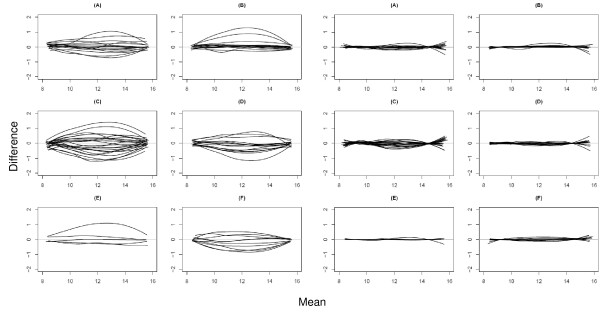
Average bias curves. Average bias curves (i.e. the loess smoothers) from MVA plots examining reproducibility in light of various systematic factors. The left set of six are pre-normalization; the right set of six are post-normalization. (A) Within plate technical replicates for the four cell lines on all four SAMs (n = 16 curves). (B) Within plate patient technical replicates for 200 ng of extraction 1 on first three SAMs (n = 15 curves). (C) Cell line technical replicates between SAMs (n = 24 curves). (D) Patient sample technical replicates between SAMs for 200 ng of extraction 1 (n = 15 curves). (E) Patient sample between extraction technical replicate for 200 ng (n = 5 curves). Replicate 1 was chosen arbitrarily. (F) Patient samples from extraction 1 comparing 25, 100, 400, 800 ng to 200 ng for two patients (n = 10 curves). Replicate 1 for 200 ng was chosen arbitrarily.